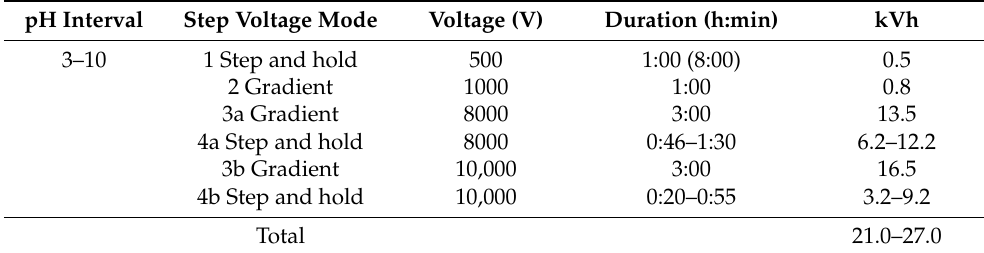
Table 2. Parameters used when running the 18 cm OFFGEL